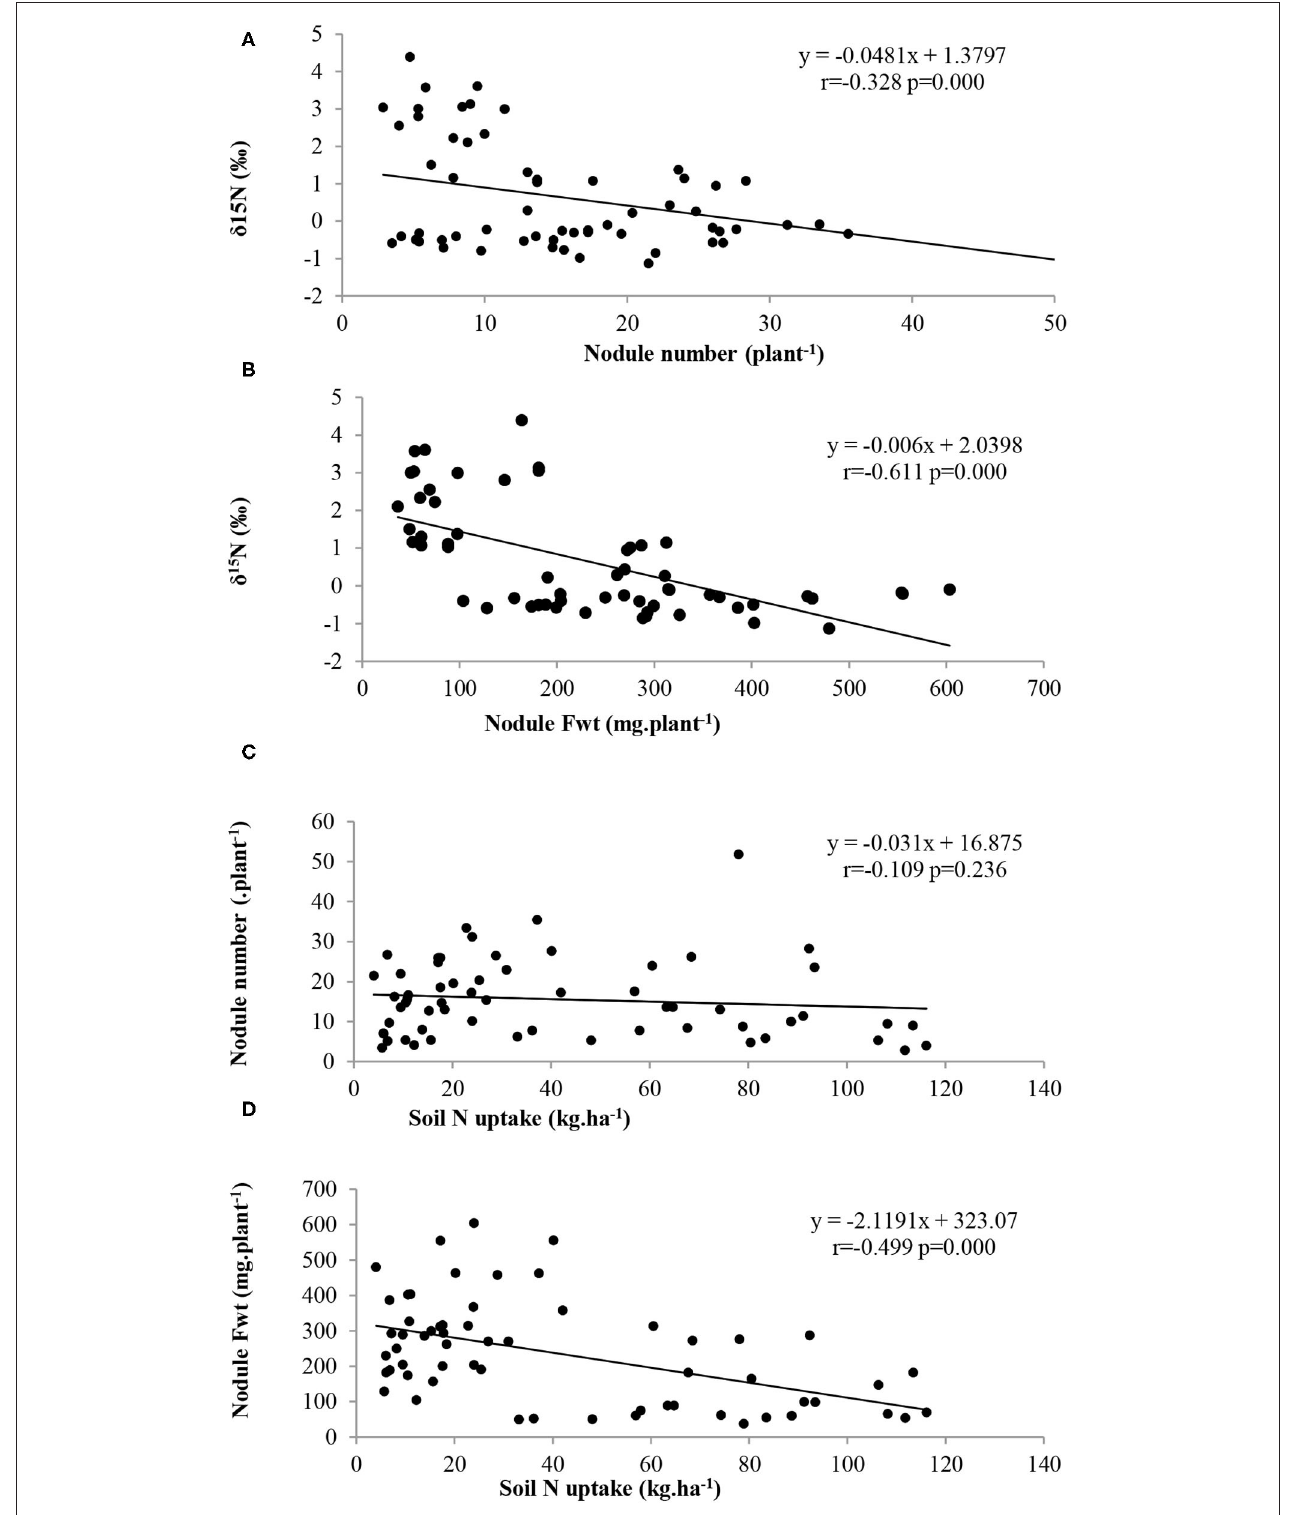
FIGURE 3 | Relationships between (A) δ 15 N and nodule number, (B) δ 15 N and nodule Fwt, (C) nodule number and soil N uptake, and (D) nodule fresh weight and soil N uptake of Bambara groundnut landraces sampled at flowering at 65 DAP.